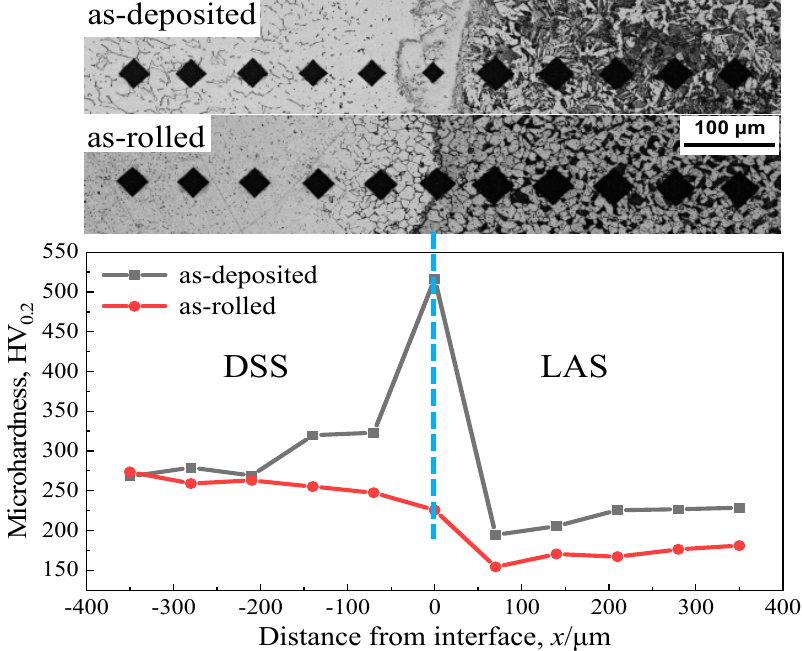
Figure 6. Variation in hardness across the interface of the fabricated samples.